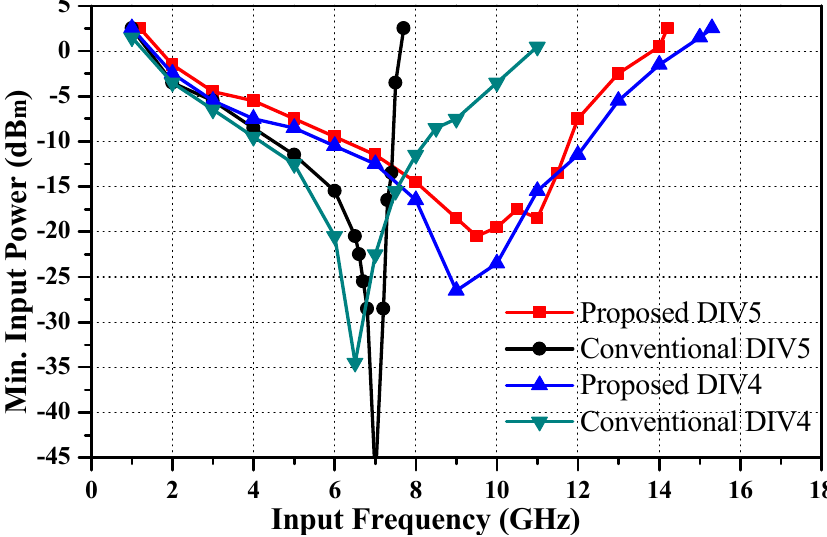
Figure 9. Measured input sensitivity curves of the conventional and proposed divide-by-4/5 prescalers.